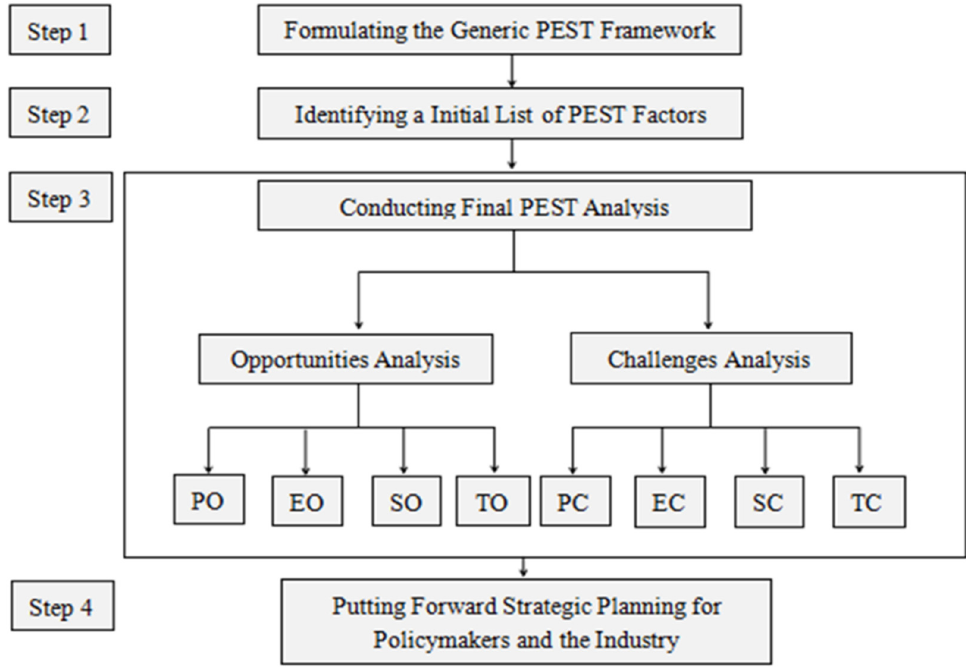
Figure 2. Research flow of the PEST analysis.